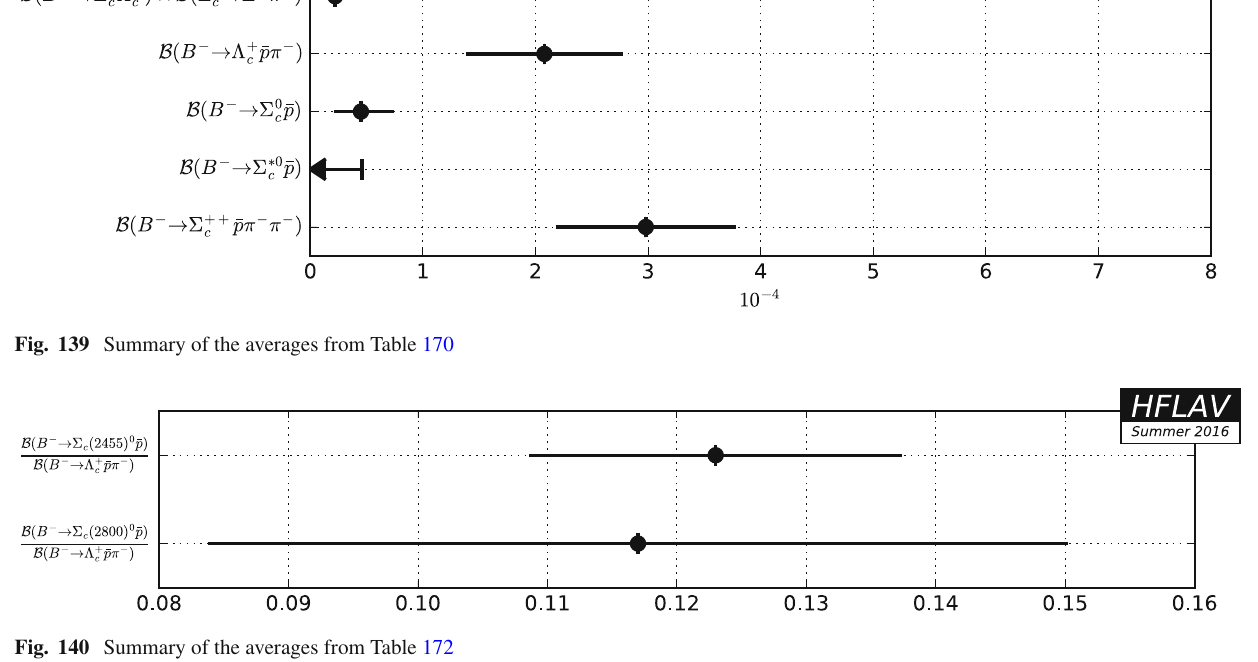
Fig. 140 Summary of the averages from Table